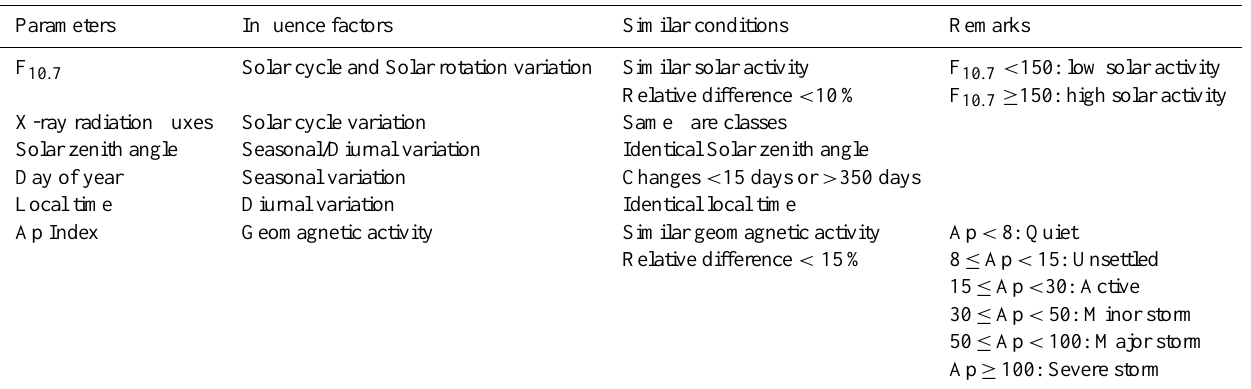
Table 3. The settings of the similar